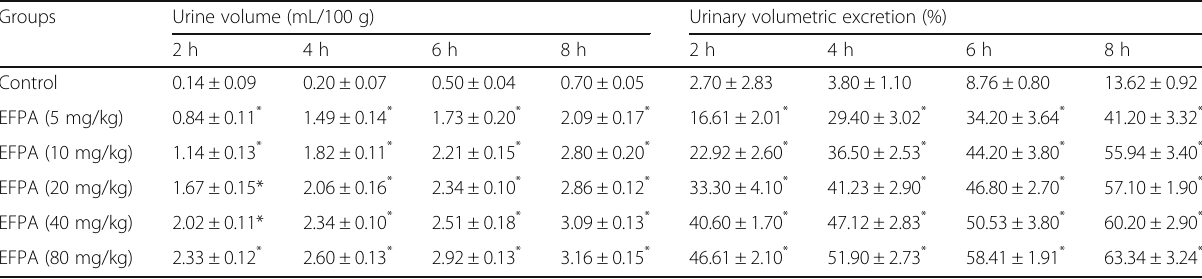
Table 1 Urinary excretion induced by increasing doses of EFPA in rats Groups